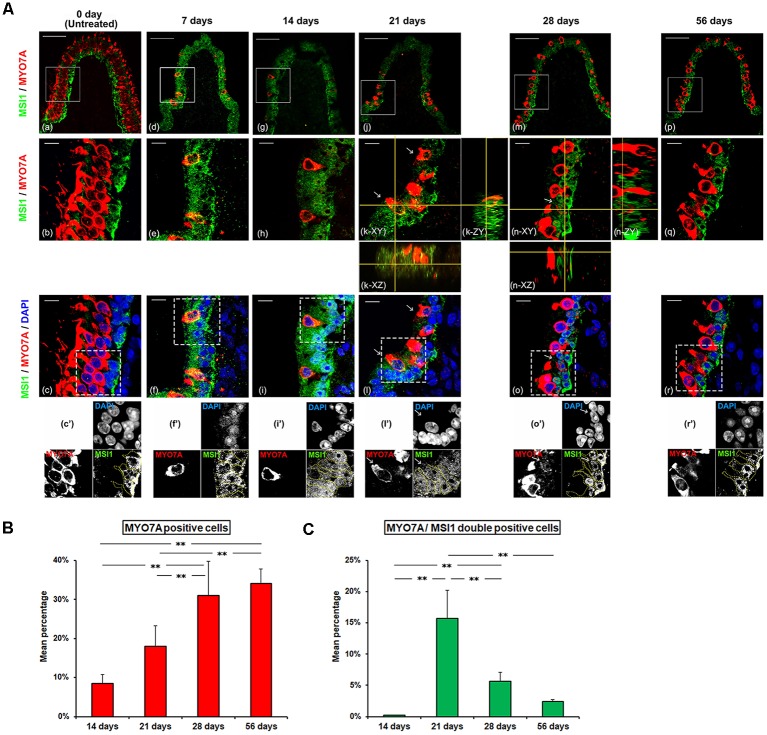
(A) Histological changes in intra-cellular localization of Musashi1 (MSIl) during spontaneous regeneration process of HCs. Each middle (b,e,h,k,n,q) and lower (c,f,i,l,o,r) panel magnifies the boxed area in the respective upper panel (a,d,g,j,m,p). Each lowest panel (c’,f’,i’,l’,o’,r’) represents grayscale image of the dot-boxed area in the respective upper panel (c,f,i,l,o,r). The area surrounded by the yellow dotted line represents SCs. Red represents anti-MYO7A labeling HCs, green represents anti-MSI1 labeling, and blue represents DAPI labeling of ds-DNA in the nuclei of cells. In untreated sections (a–c), SCs showed positive MSI1-immunoreactivity confined to their nuclei while HCs were negative. At 7 and 14 days PT, HCs were no longer existent, and SCs were diffusely immunostained with MSI1 (d–i). At 21 and 28 days PT (j–o), MYO7A-positive HCs, with nuclei frequently positive for MSIl, were recognized (arrow). MSI1-immunoreactivities of SCs were gradually returned to the nuclear predominance. At 56 days PT (p–r), MSI1 was nuclear predominance of SC. MYO7A-positive cells were frequently negative for MSI1. Scale bar = 50 μm (a,d,g,j,m,p), Scale bar = 10 μm (b,c,e,f,h,i,k,l,n,o,q,r). (B) The change of mean percentage (Mean ± SD) of MYO7A positive cells. MYO7A positive cells showed a progressive increase with significant differences throughout the period from 14 to 56 days PT. (C) The changes of mean percentage (Mean ± SD) of MSI1/MYO7A double-positive cells. MYO7A/MSI1 double-positive cells increased significantly during the period from 14 to 21 days PT, followed by a significant decrease from 21 to 56 days PT. **p < 0.01.